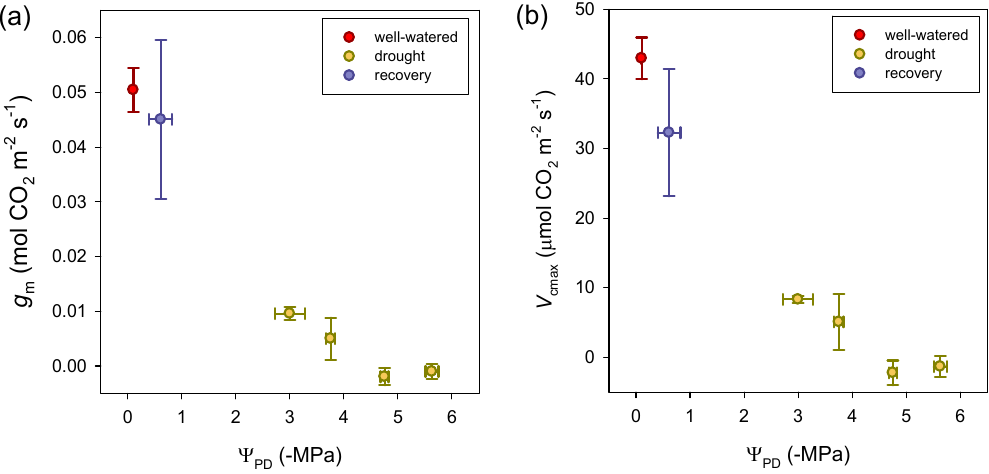
Figure 3. Time course of ( a ) mesophyll conductance ( g m ) and ( b ) maximum velocity of carboxylation ( V cmax ) with predawn water potential ( ψ PD ) for holm oak leaves well-watered (red symbols), during the drought period (yellow symbols) and 7 days after plants were re-watered (violet symbols). Data are mean ± SE.